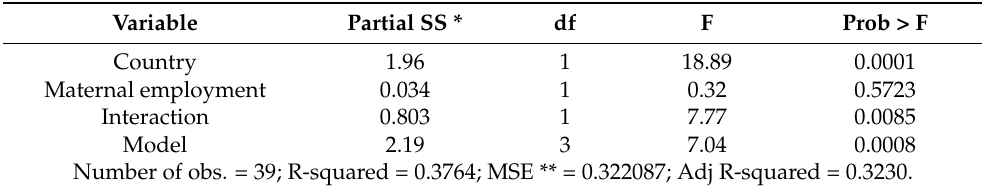
Table 5. Results of the two-way ANOVA